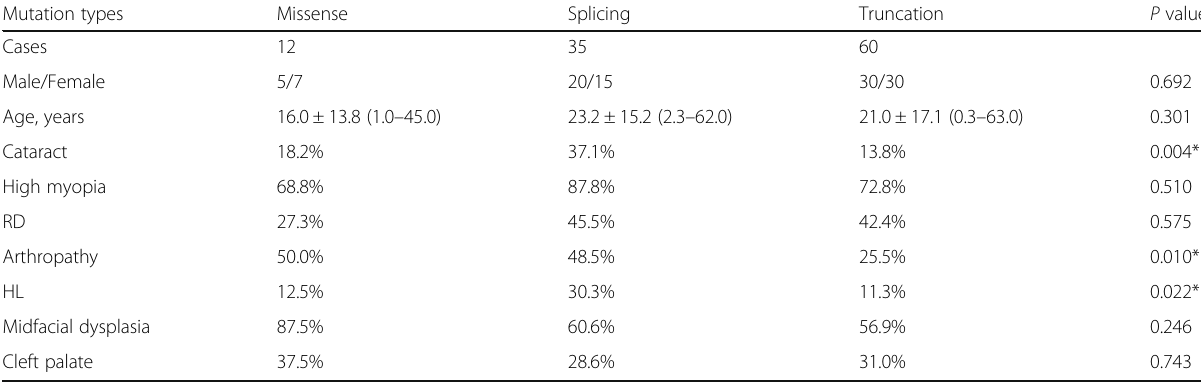
Table 1 The Difference of Phenotypes in Patients with Different Mutation Types Mutation